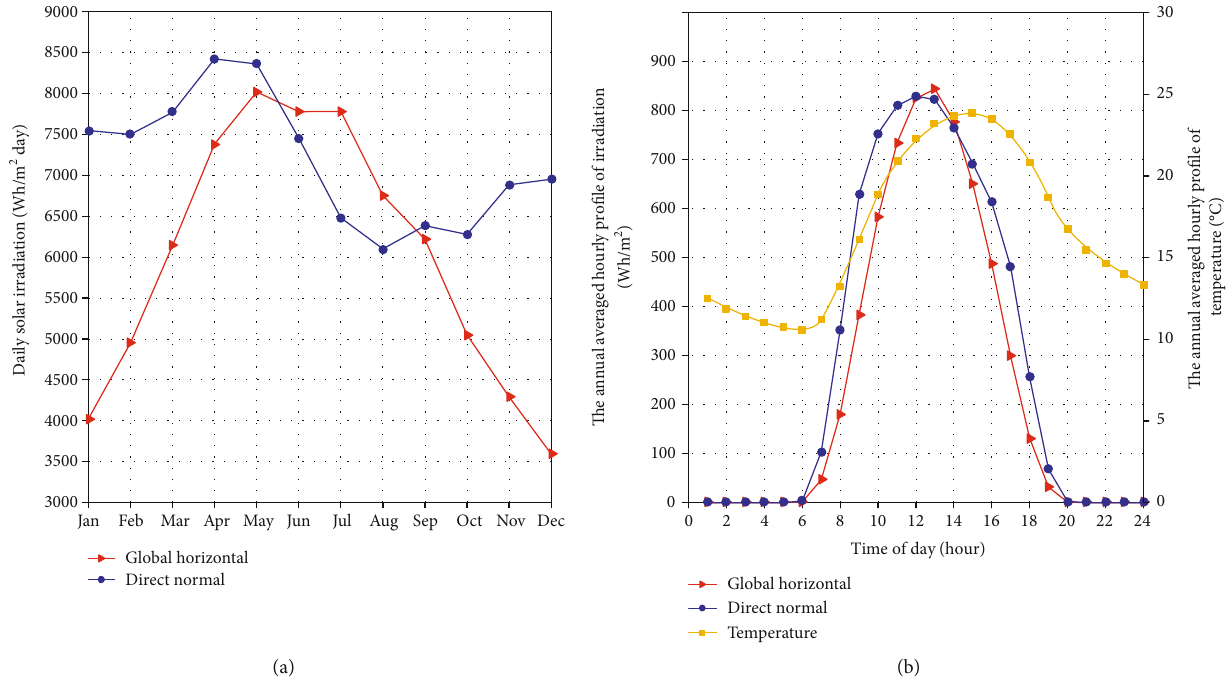
Figure 1: (a) Monthly average values of global and direct irradiation for Ouarzazate. (b) The annual averaged hourly global horizontal irradiation, direct normal irradiation, and temperature pro fi le for